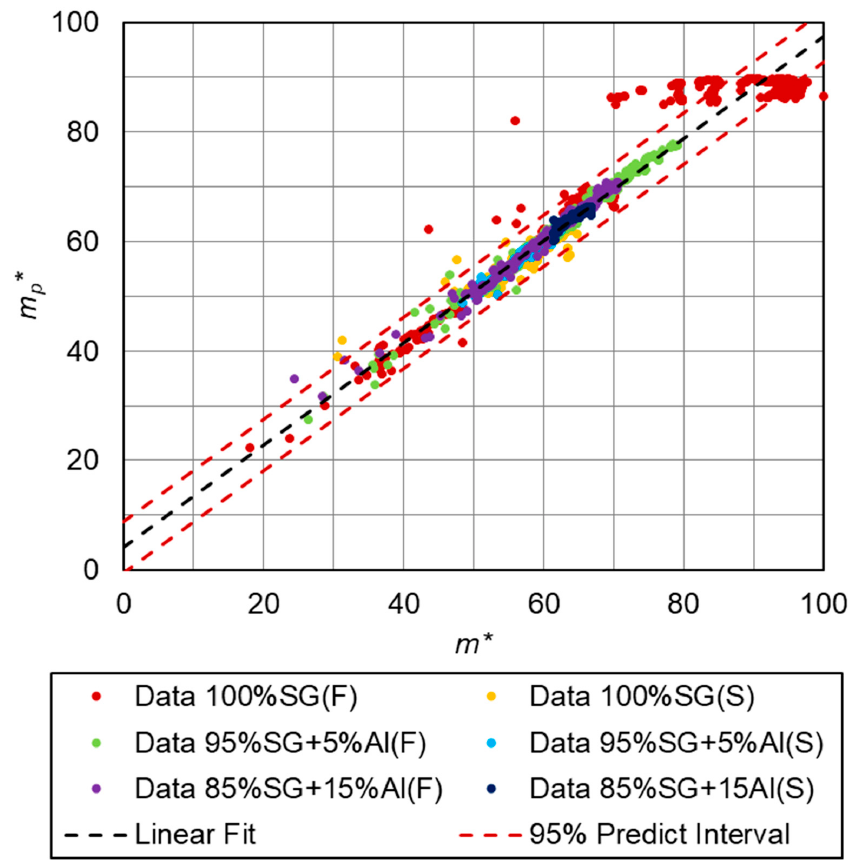
Figure 9. Comparison of the experimental results with the numerical results predicted by the LSTM (60-20-20). (60-20-20).